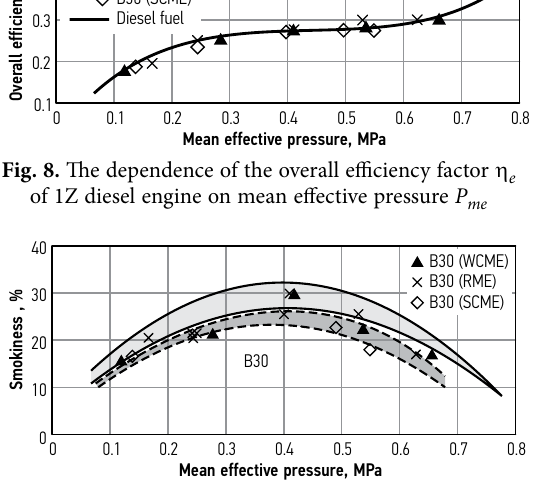
Fig. 9. The dependence of the smokiness SM of 1Z diesel engine on mean effective pressure P me